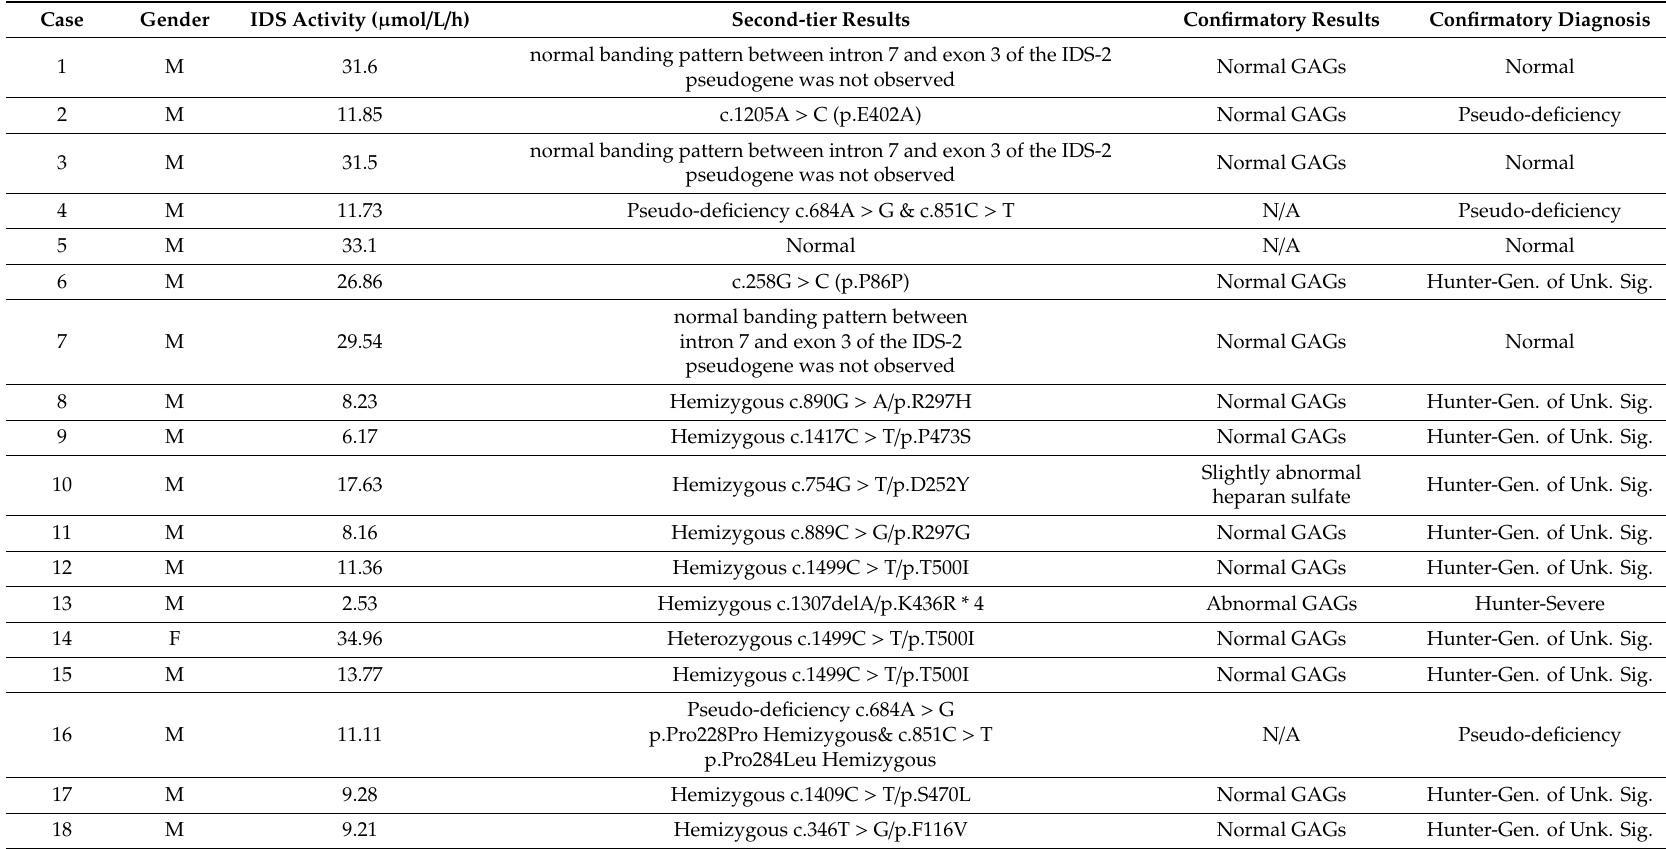
Table 5. First Tier, Second Tier and Confirmatory Test